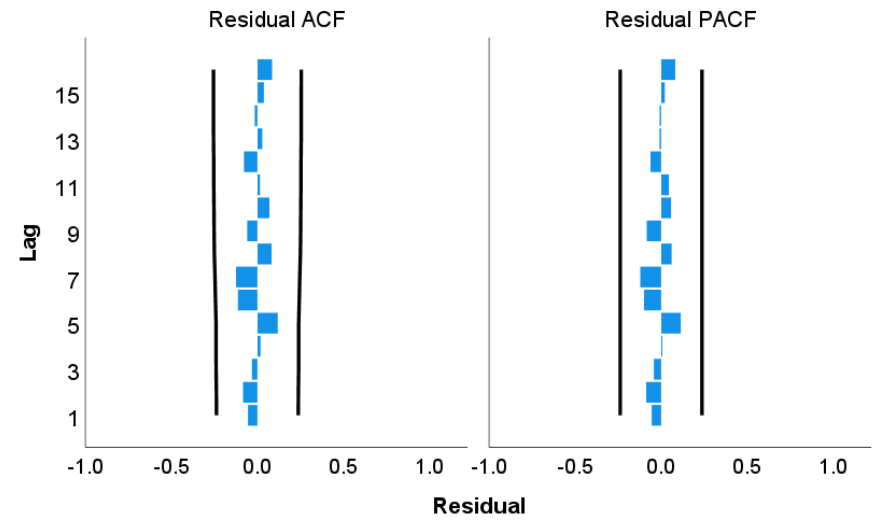
Figure 6. Residual ACF and PACF plot for Albany.